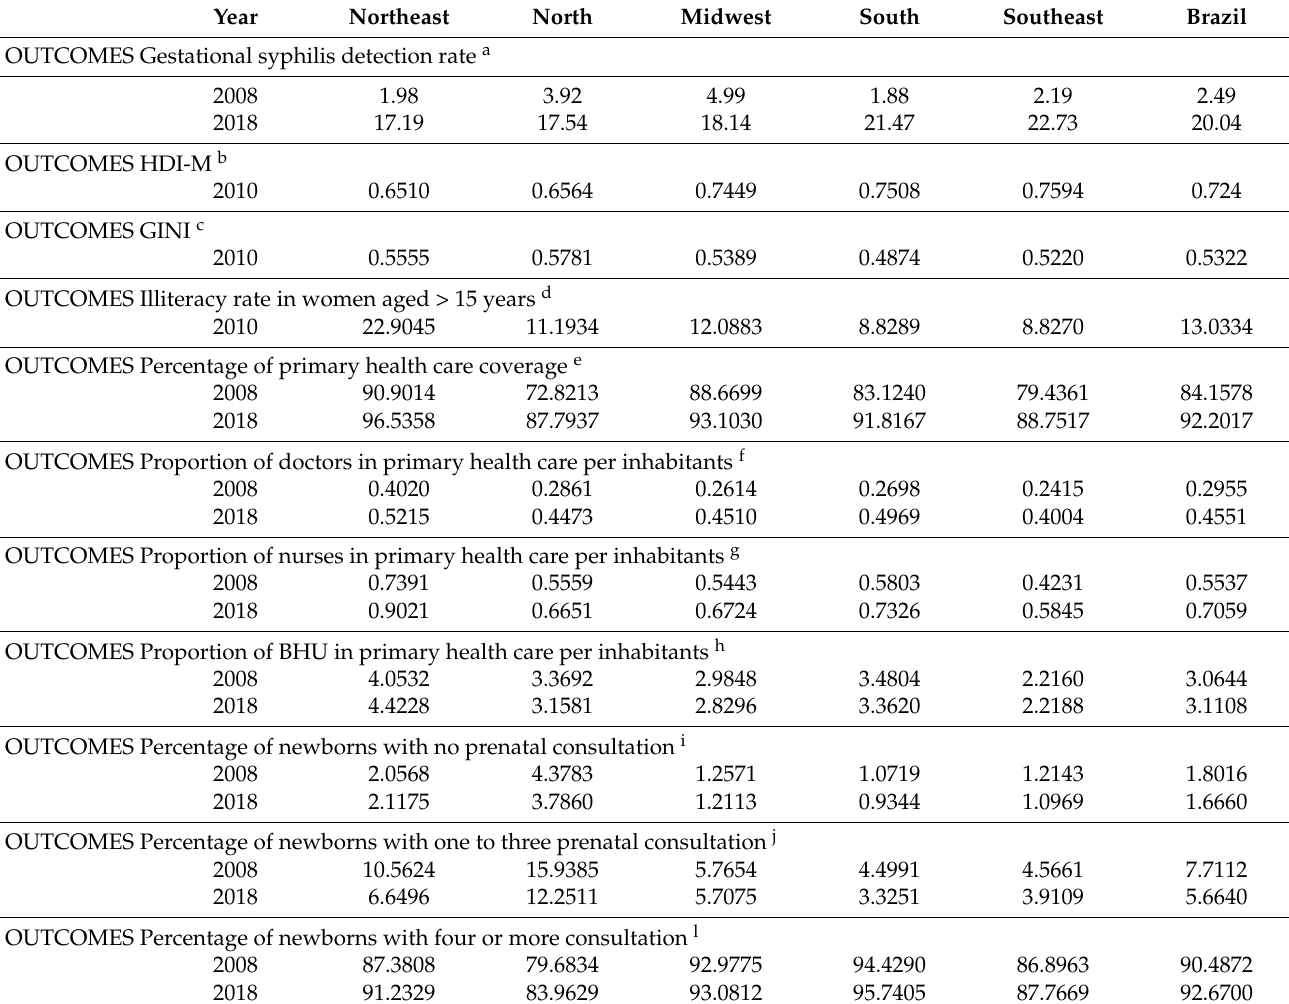
Table 2. Gestational syphilis detection rate, socioeconomic variables, and health services from 2008 and 2018, divided by Brazilian